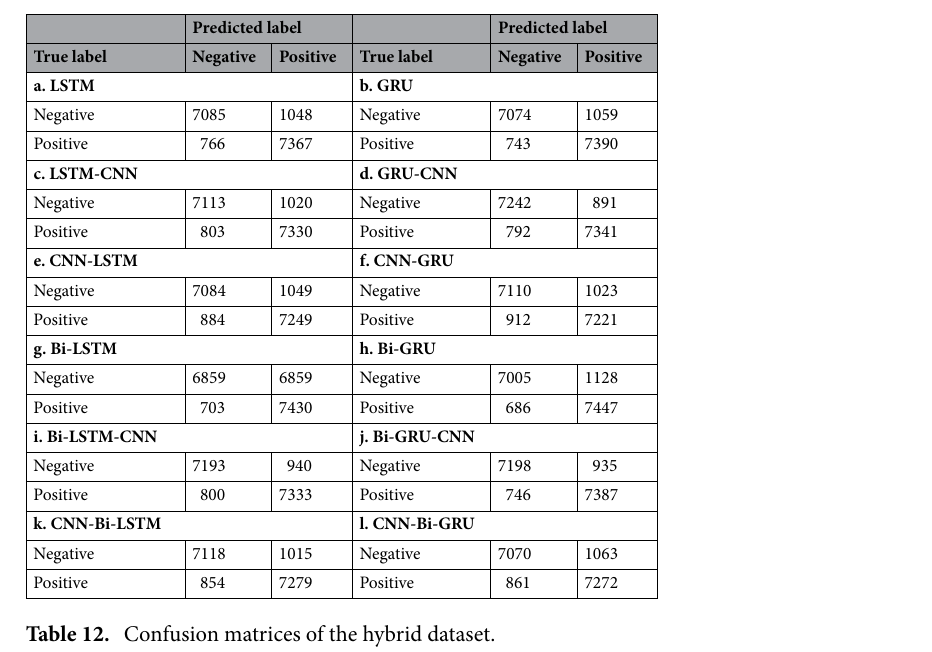
Table 12. Confusion matrices of the hybrid